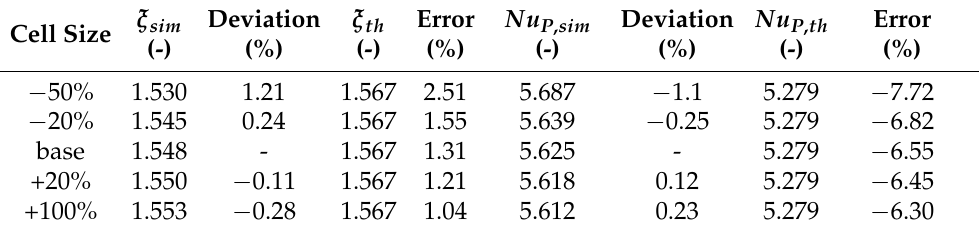
The cell size dependence of the simulations was investigated by varying the cell size of the mesh. Steady-state drag coefficient and Nusselt numbers are compared with literature values to assess the suitability of the mesh. The Whitaker Nusselt correlation (Equation (5)) is used for the heat transfer comparison. The base mesh consists of 60,000 cells. The investigated mesh variations and the results of the grid independence study are given in Table A4. The difference between the simulated drag coefficient and the theoretical one is below 3% for any case. The deviations between simulated Nusselt number and the Whitaker correlation are below 8%. Table A4. Cell size study of reference particle cases for Re P =